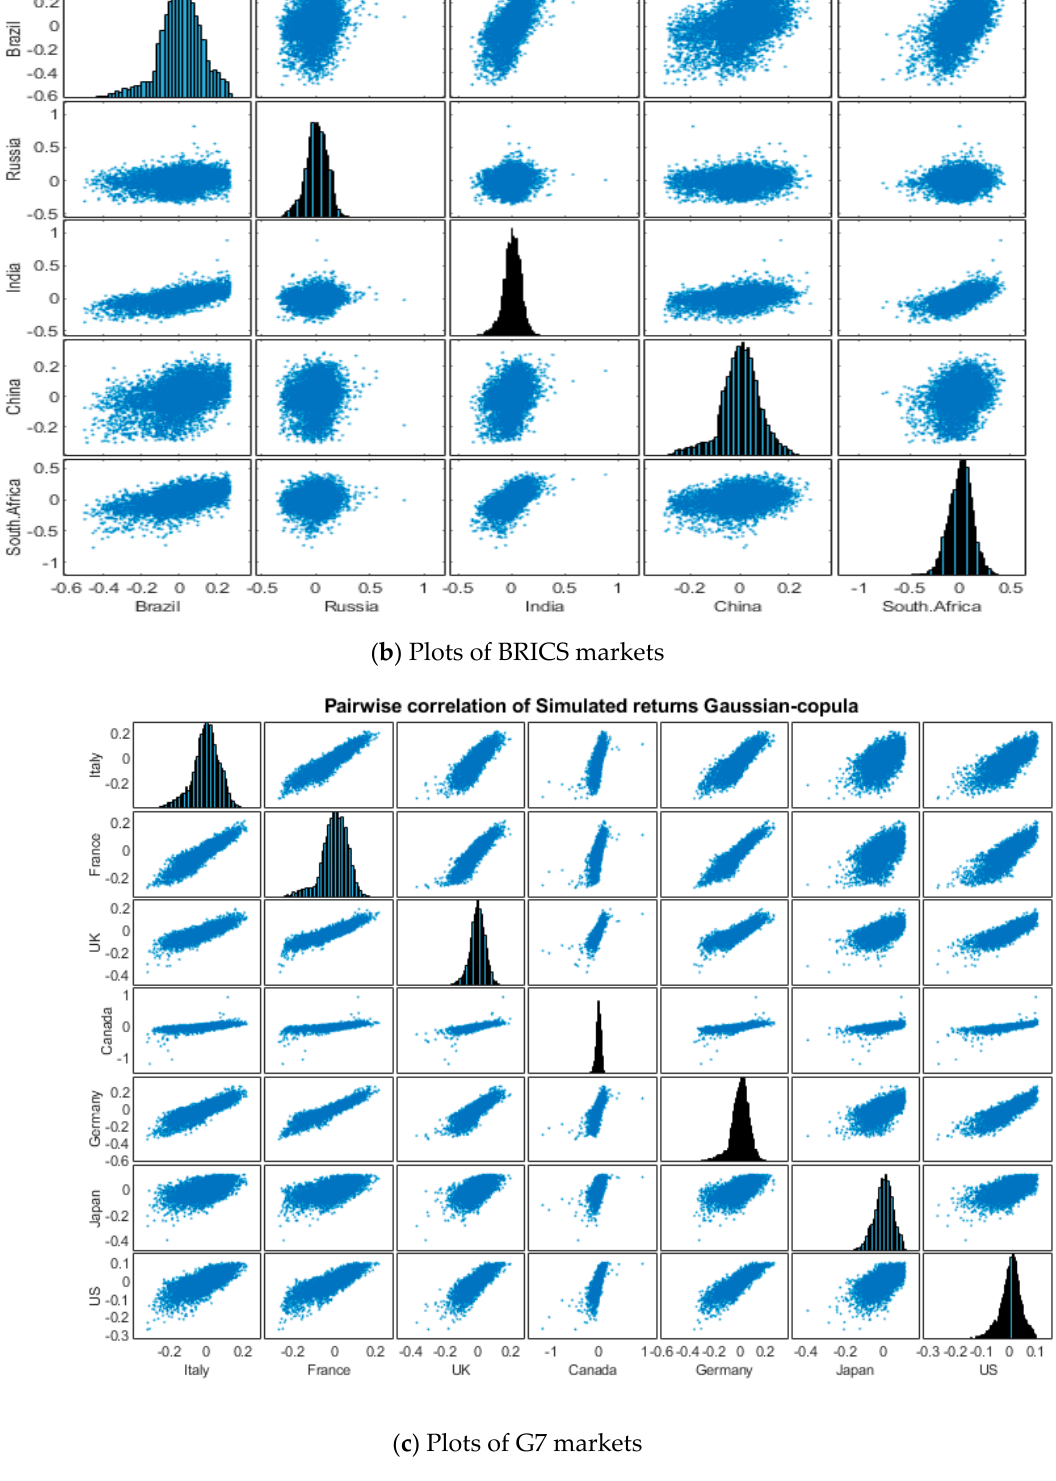
Figure 5. Pairwise correlation of simulated returns, Gaussian-copula.